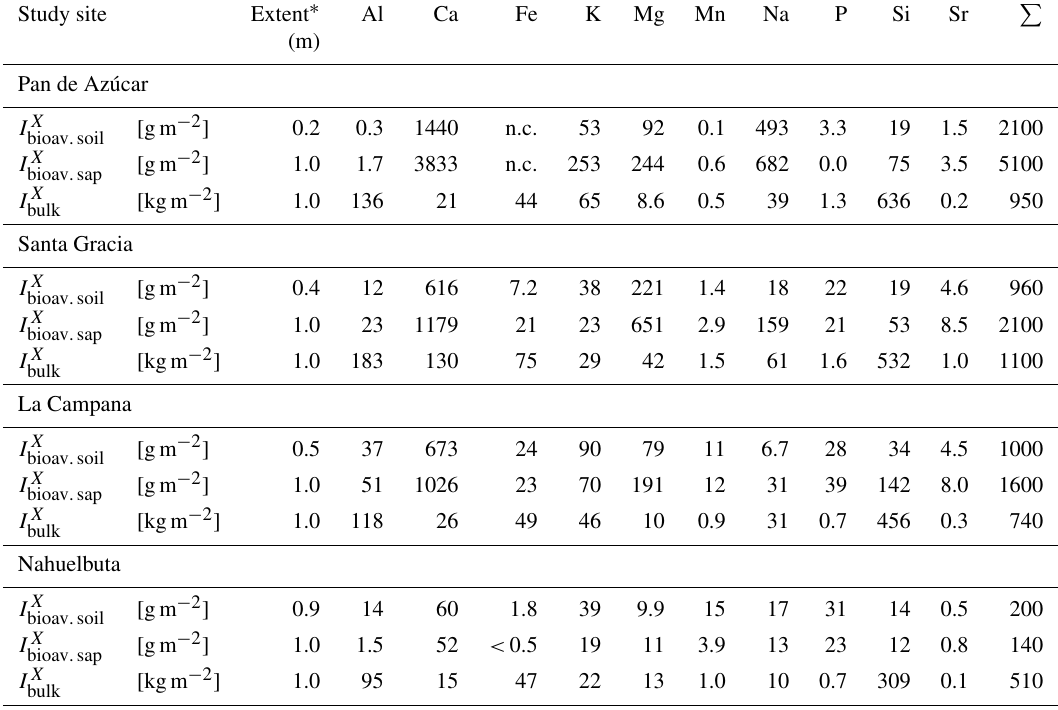
Table A1. Inventories of elements in bulk regolith and the bioavailable fraction in soil and saprolite. Apart from phosphorus, the accessibility of these elements was determined using a sequential extraction method described by Arunachalam et al. (1996); Tessier et al. (1979); He et al. (1995). P accessibility in the bioavailable fraction has been determined by Brucker and Spohn (2019) using a modified Hedley sequential P fractionation method. Data Tables S3 and S4 include depth-dependent concentrations of the bioavailable fraction (pooled) and the deionized and NH 4 OAc extractions used for calculation of the